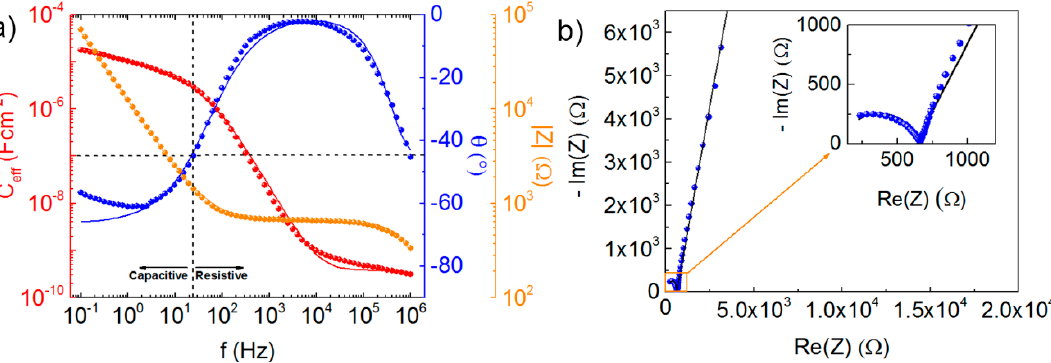
Figure 2. ( a ) The measured effective capacitance, phase, and impedance variation with frequency and ( b ) the respective Nyquist plot of the composite solid polymer electrolyte (CSPE ) .